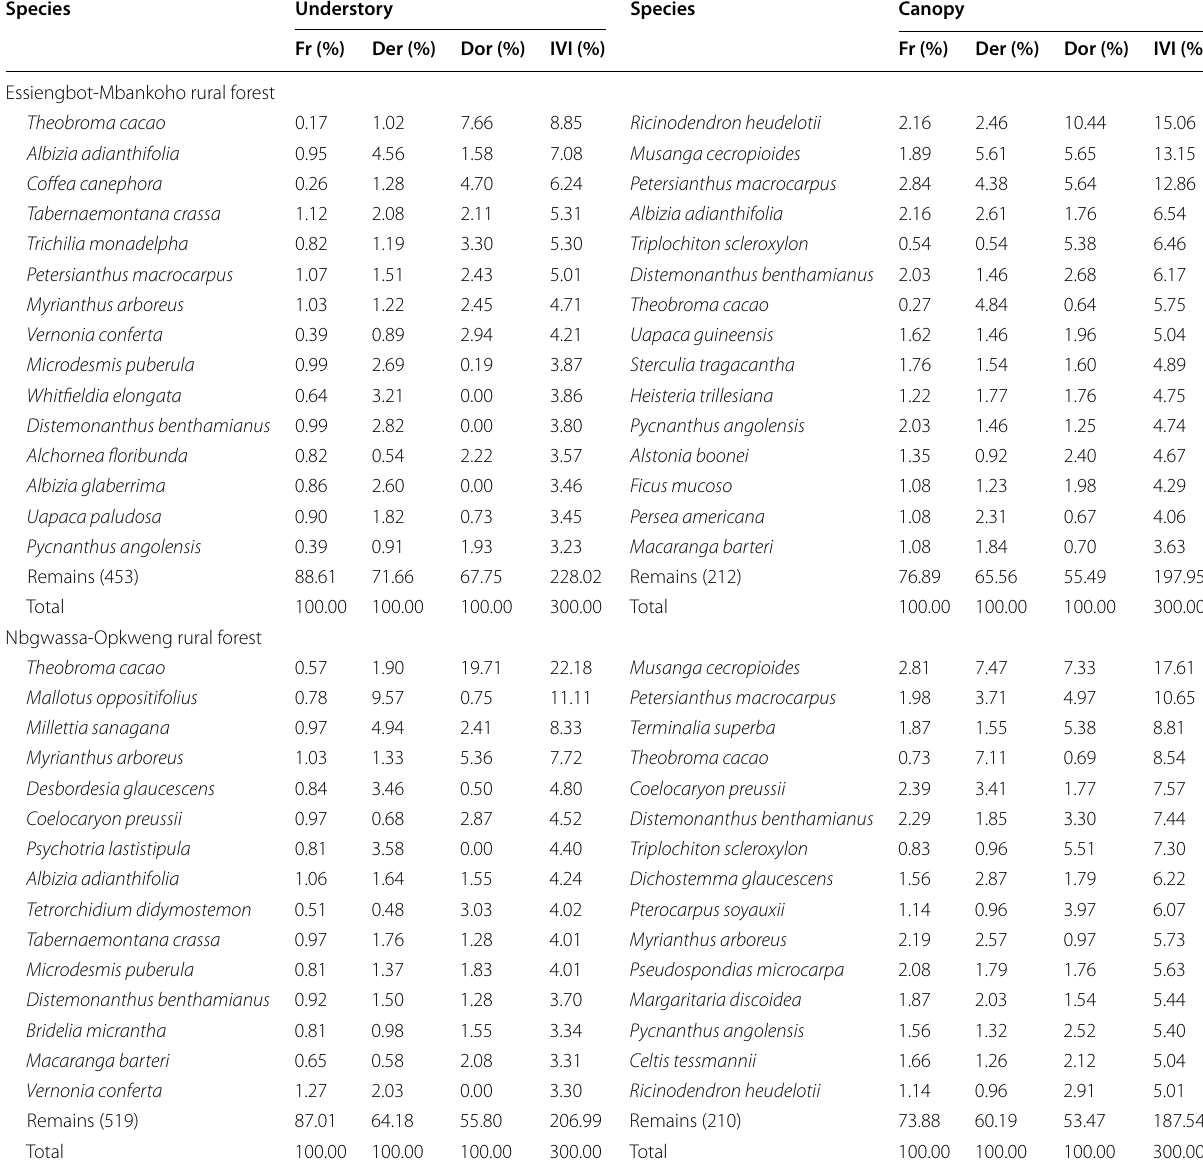
Table 1 The 15 most important species in the understory and canopy in each rural forest according to decreasing order of importance value